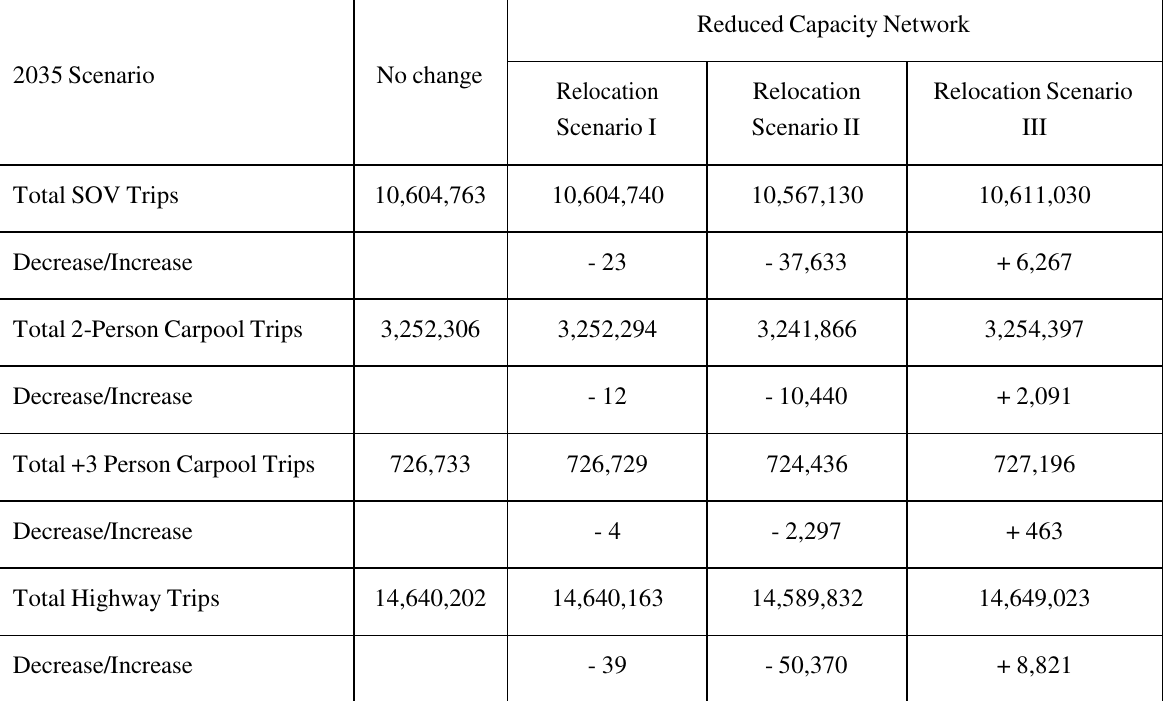
Table 3 Summary of the model results for the total trips